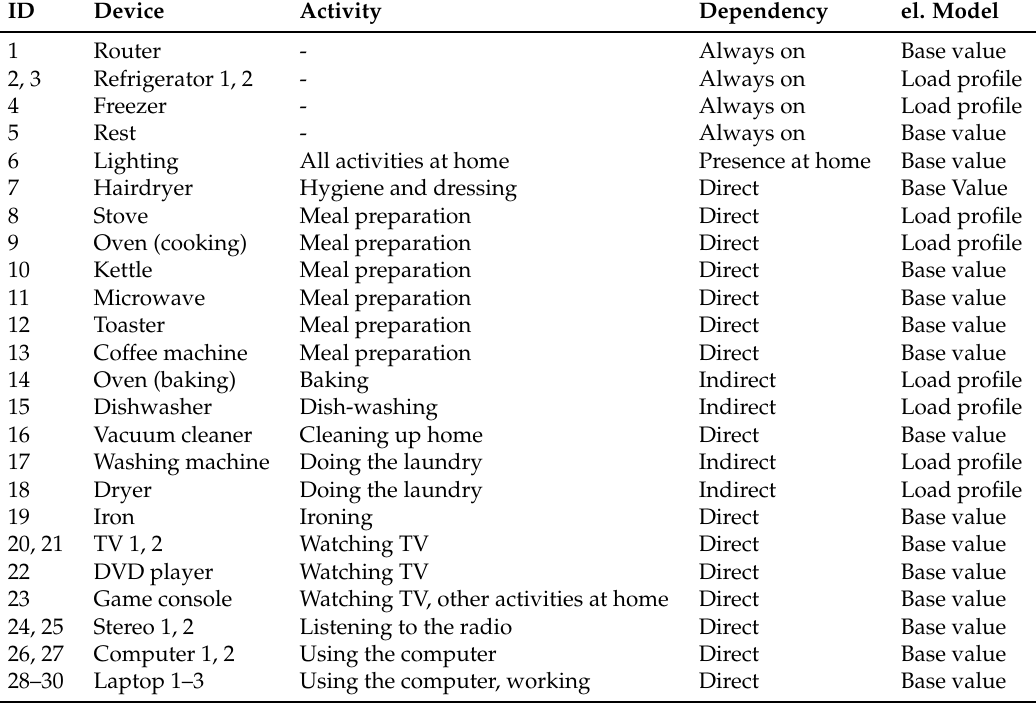
Table 5. Overview of the electrical devices, the corresponding activities, dependencies and the type of electrical